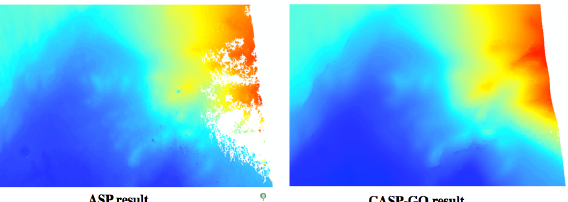
Figure 4. An example of MSL DTMs derived from CTX stereo, showing un-matched areas from ASP processing (left) and improved completeness using Gotcha densification in CASP- GO (right).